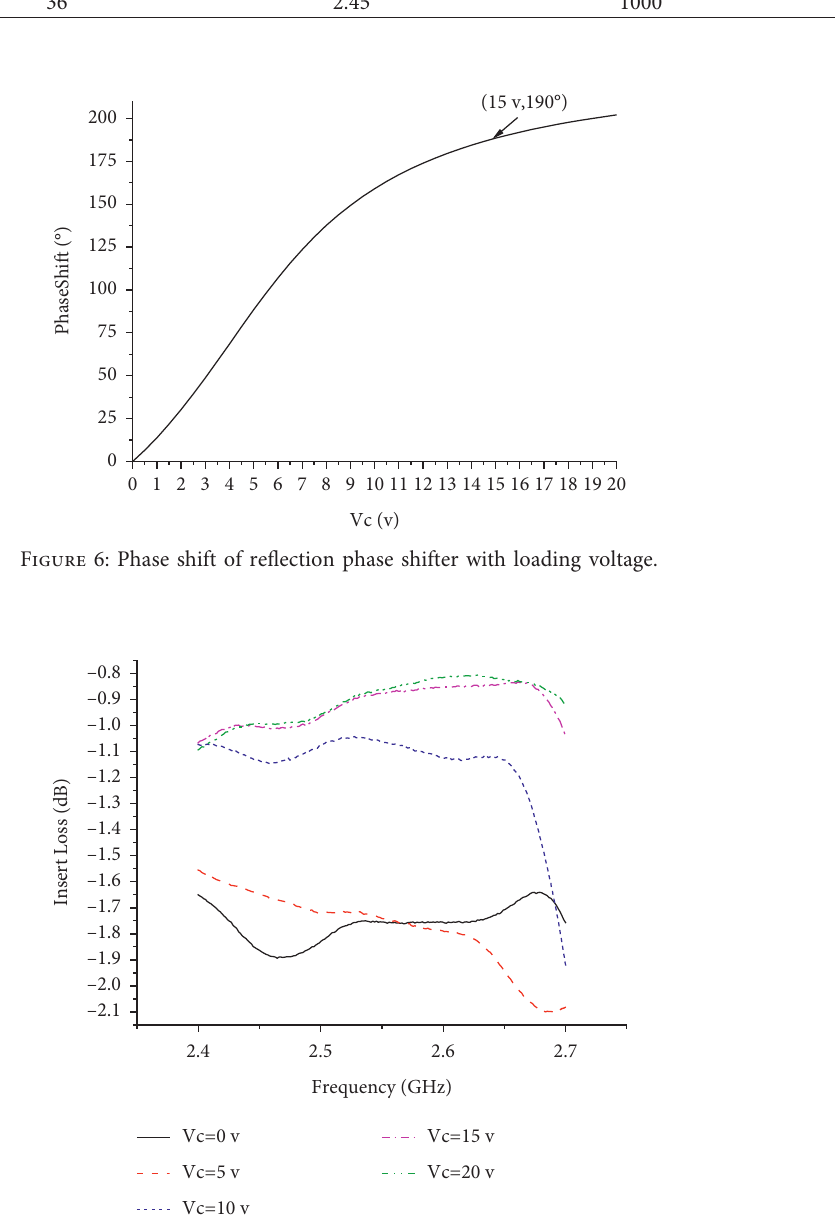
Figure 7: Measured insert loss